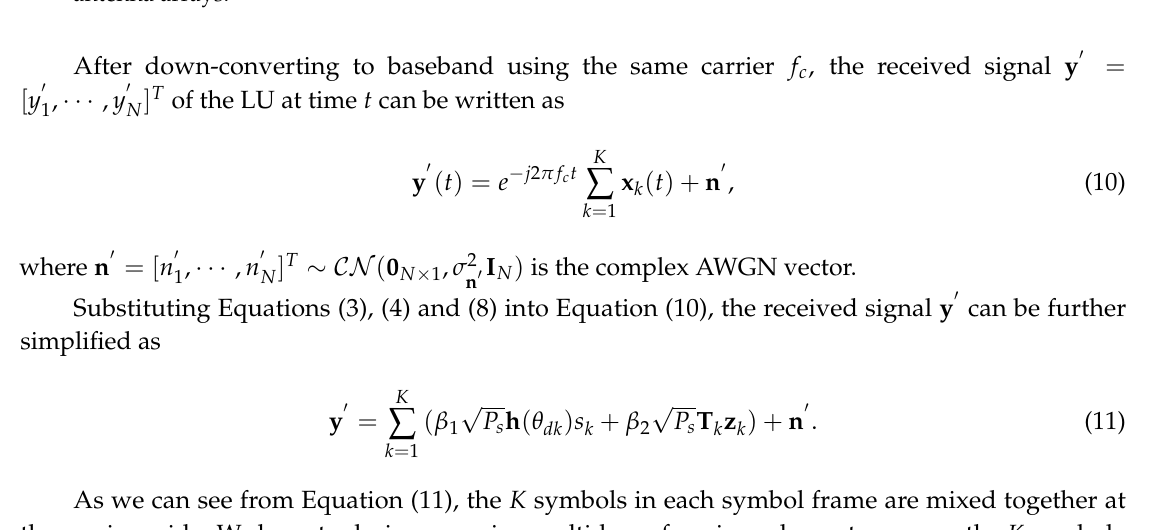
Figure 4. The architecture of the LU for the proposed DM based on a single-carrier multiple antenna